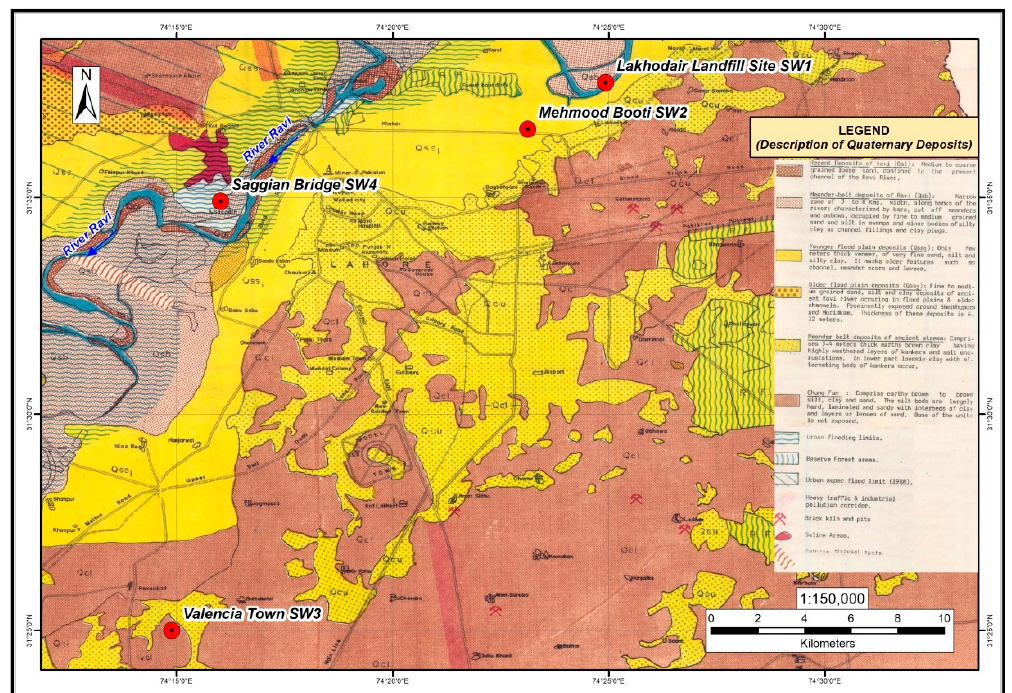
Figure 1. A map of sampling locations in Lahore.